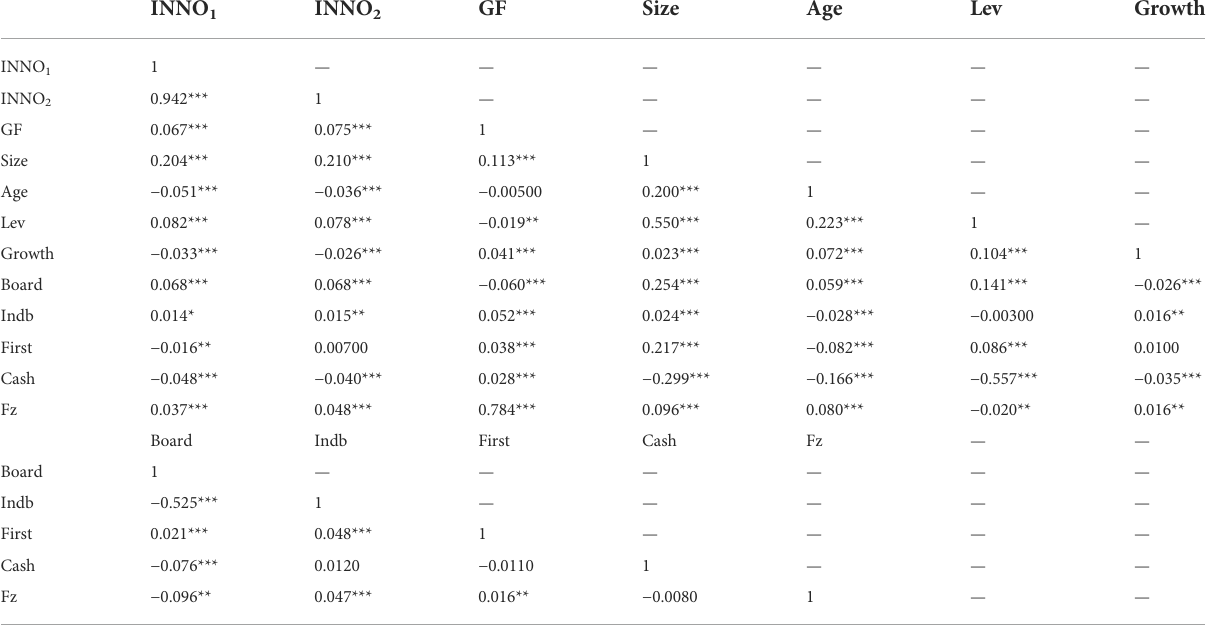
TABLE 2 Correlation coef fi cient analysis of major